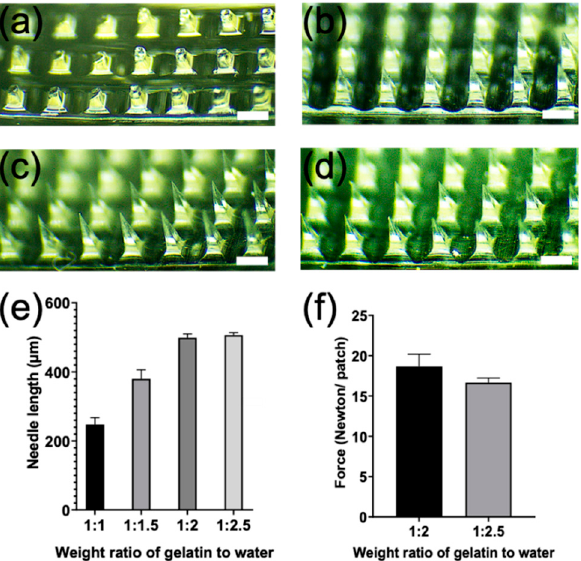
Figure 1. Brightfield microscope images of microneedles arrays. Microneedles were fabricated with a various weight ratio of gelatin to water at ( a ) 1:1; ( b ) 1:1.5; ( c ) 1:2; and ( d ) 1:2.5; ( e ) the needle length of microneedles with various weight ratios of gelatin to water; and ( f ) the mechanical failure of microneedles by comparing the weight ratio of 1:2 with 1:2.5 component of microneedles. Scale bar equals 200 µ